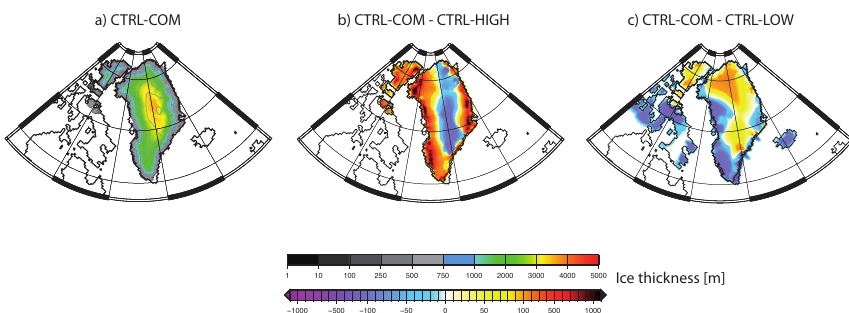
Figure 5. (a) CTRL-COM ice sheet thickness at the end of the experiments (m); (b) difference in ice sheet thickness at the end of the model runs CTRL-COM minus CTRL-HIGH; (c) difference in ice sheet thickness at the end of the model runs CTRL-COM minus